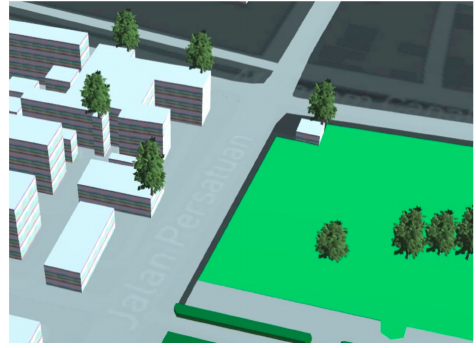
Figure 13. Misplaced 3D trees outside of forest